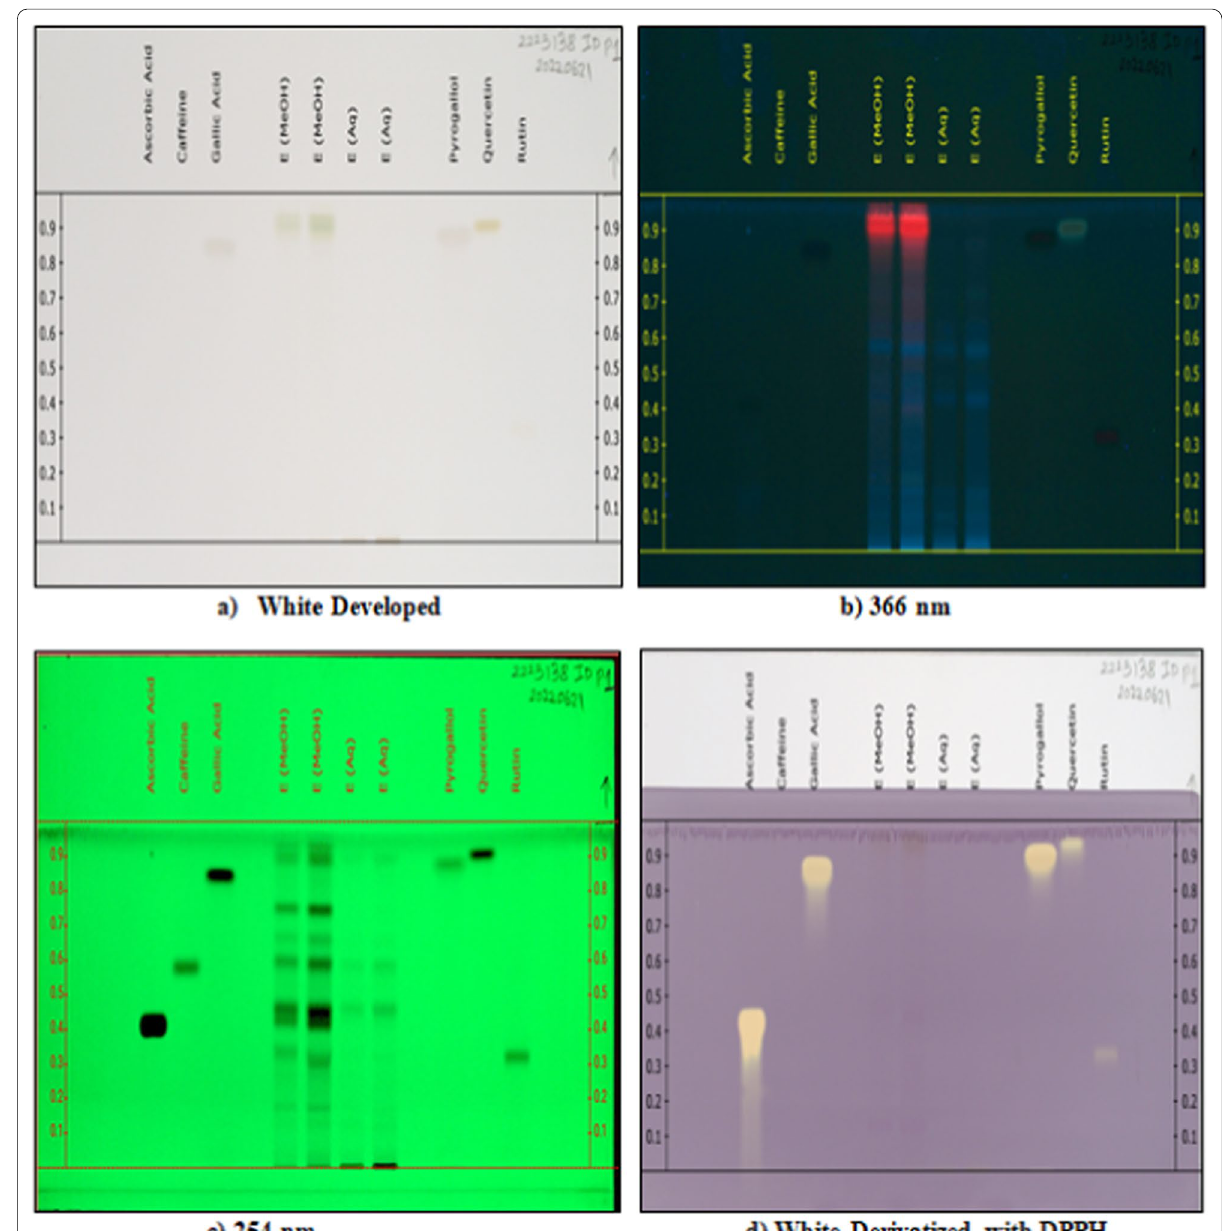
Fig. 2 HPTLC band chromatogram using solvent system A (ethyl acetate/methyl ethyl ketone/formic acid/water in the ratio of